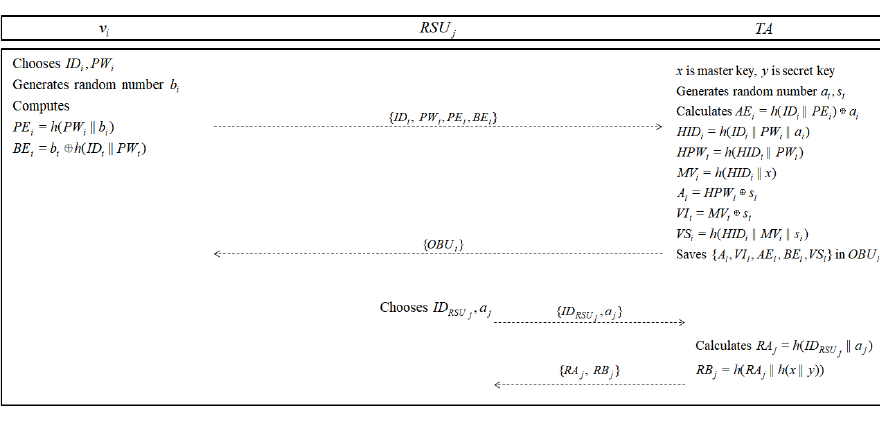
Figure 5. Registration phase of our proposed